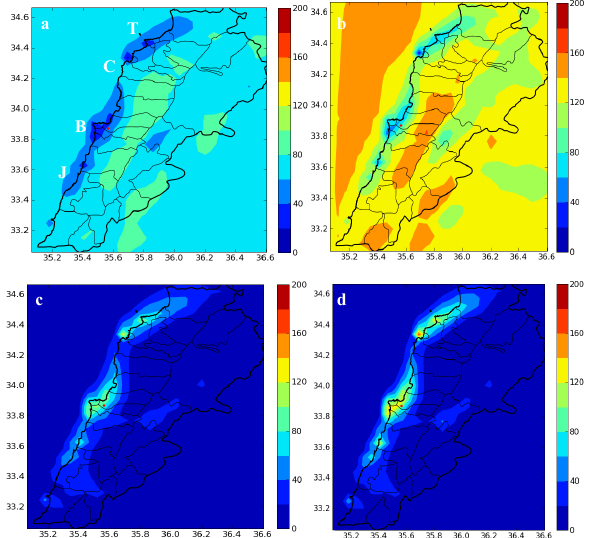
Figure 4. Modeled average O 3 concentrations ((a) simulation A1 and (b) simulation A4) and NO 2 concentrations ((c) simulation A1 and (d) simulation A4) in µg/m 3 for the inner domain D2. The red dot corresponds to the location of the measurement site at USJ during July 2011.